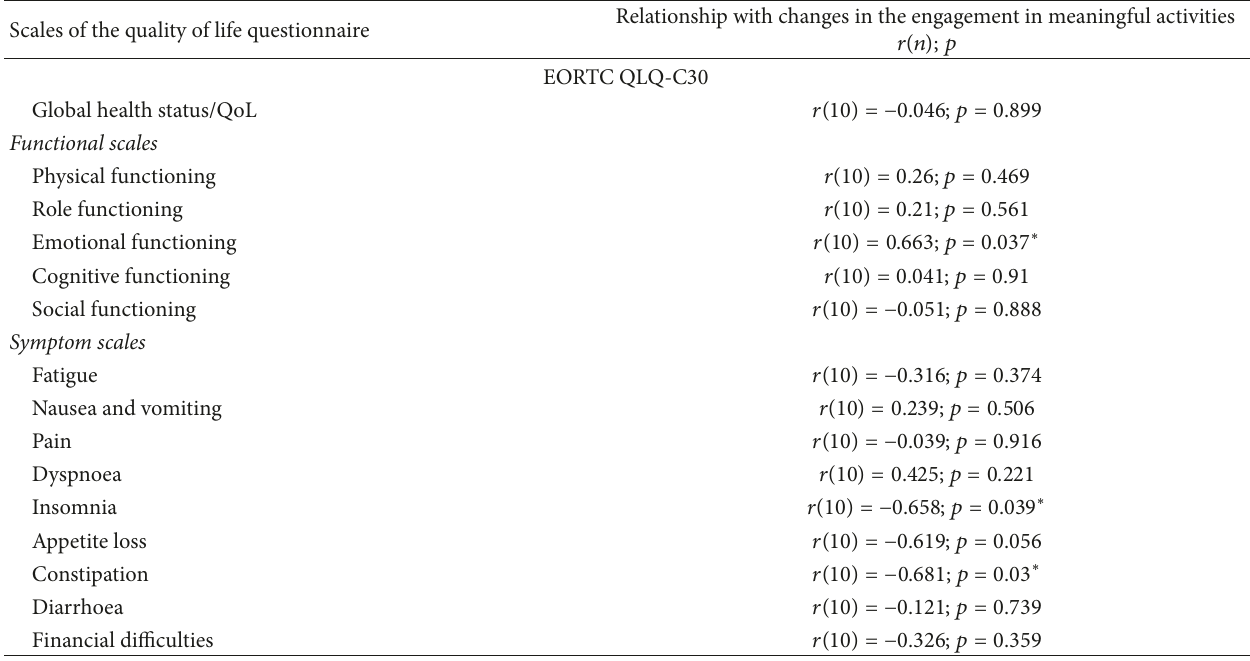
Table6:Relationshipbetweenengagementinmeaningfulactivitiesandevaluationsscoresofhealth-relatedqualityoflife(EORTCQLQ-C30) in women with breast cancer.